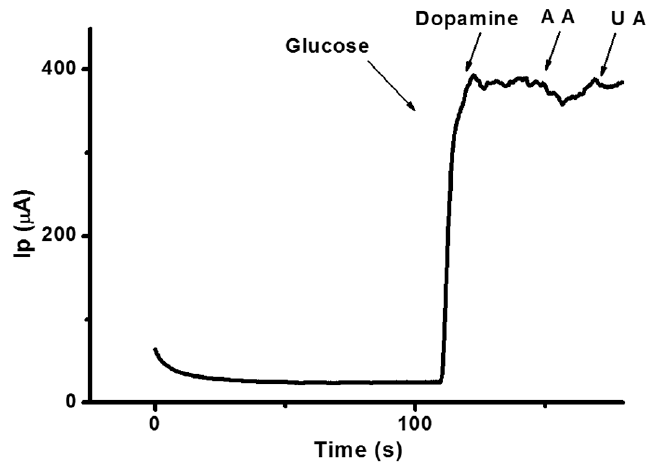
Figure 6. Amperometric current-time response curves for the sequential addition of 0.1 mM aliquots of glucose, dopamine, ascorbic acid, and uric acid.